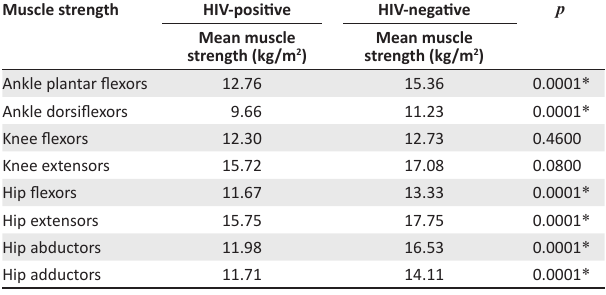
TABLE 3: Comparison of 30 HIV-negative and 30 HIV-positive participants on highly active antiretroviral therapy (matched groups) lower limb muscle strength. Muscle